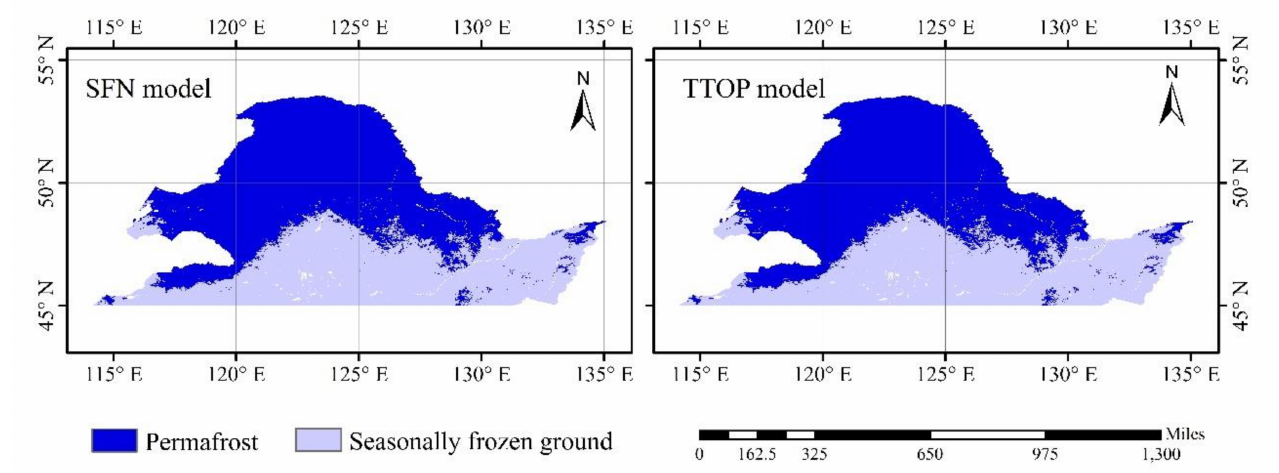
Figure 2. Simulated permafrost distribution in Northeast China from 2001 to 2018. Spatial distribution of simulated SFN ( ≥ 0.5) in Northeast China is shown in Figure 3. SFN value was the highest in the north part of Da Xing’anling Mountains and the lowest in Xiao Xing’anling Mountains. Spatial distribution of simulated MAGT (<0 ◦ C) in Northeast China is shown in Figure 4. MAGT value was the highest in Xiao Xing’anling Mountains and the lowest in the north part of Da Xing’anling Mountains. In summary, permafrost area with a higher SFN value had a relatively lower MAGT value.